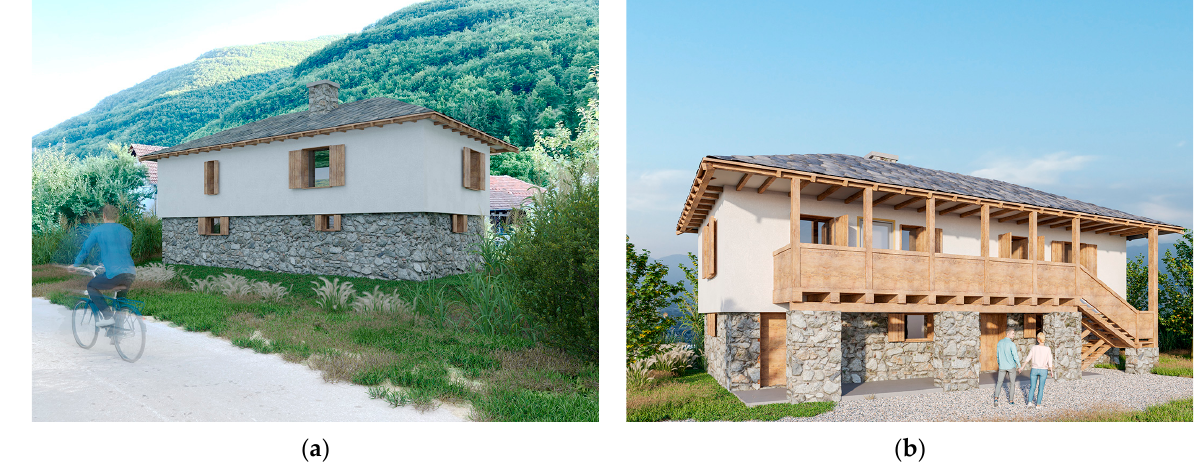
Figure 5. Three-dimensional rendering (renovation): ( a ) street view and ( b ) courtyard view. Table 1. Outer wall